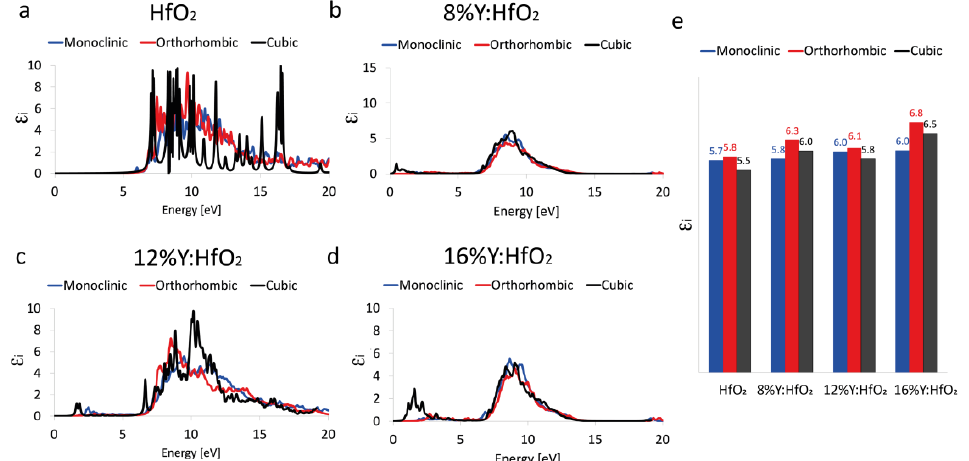
Figure 4. Imaginary part of the dielectric constant. ε i of monoclinic P2 1 /c (blue curve), orthorhombic Pca2 1 (red curve), and cubic Fm 3̅ m (black curve) polymorphs evaluated between 0 and 20 eV of HfO 2 ( a ), 8% Y:HfO 2 ( b ), 12% Y:HfO 2 ( c ), and 16% Y:HfO 2 ( d ). Schematic trend of ε i at the main absorption peak as a function of the crystalline phase and Y content ( e ).